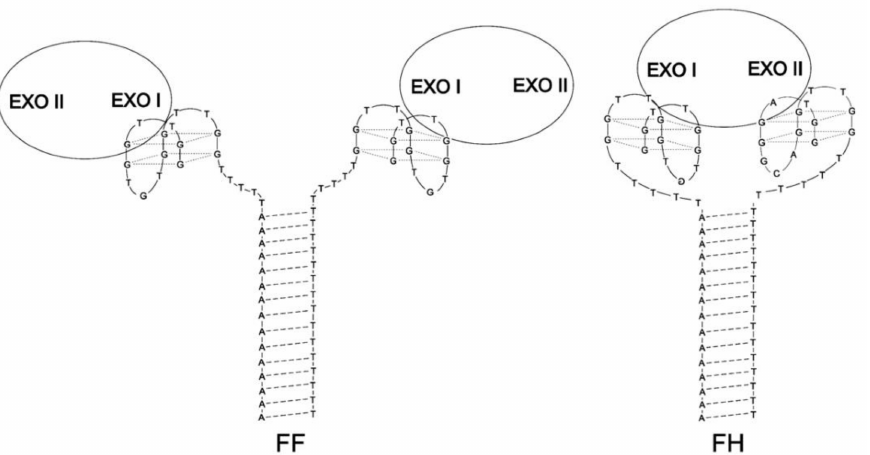
Figure 15. The structure of FF ( left ) and FH ( right ) dimers [66]. The FF dimer binds two thrombin molecules in their exosite I, whereas the FH dimer interacts with one thrombin molecule, but in two different binding sites: exosite I and II. Reproduced with permission from Elsevier, © 1997 Academic Press Limited and IUCr Journals, © 2013 International Union of Crystallography Printed in